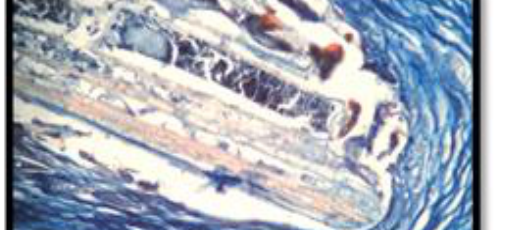
Figure,17: UBM-treatment group at 16th week post implantation, shows regular collagen fibers infiltrated with MNCs which attached to host muscular layer and incorporation of new collagen (H&E stain,200X)